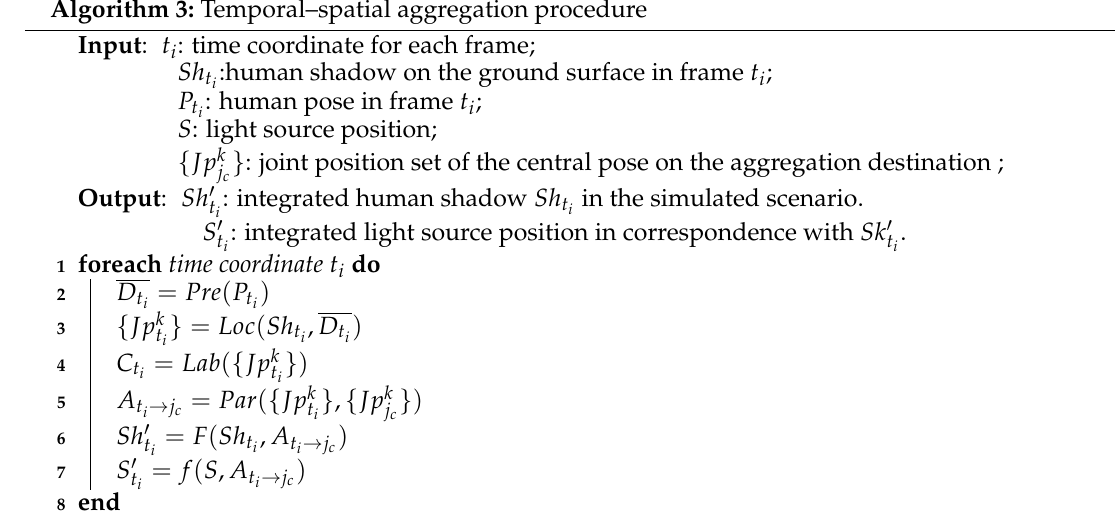
Algorithm 3: Temporal–spatial aggregation procedure